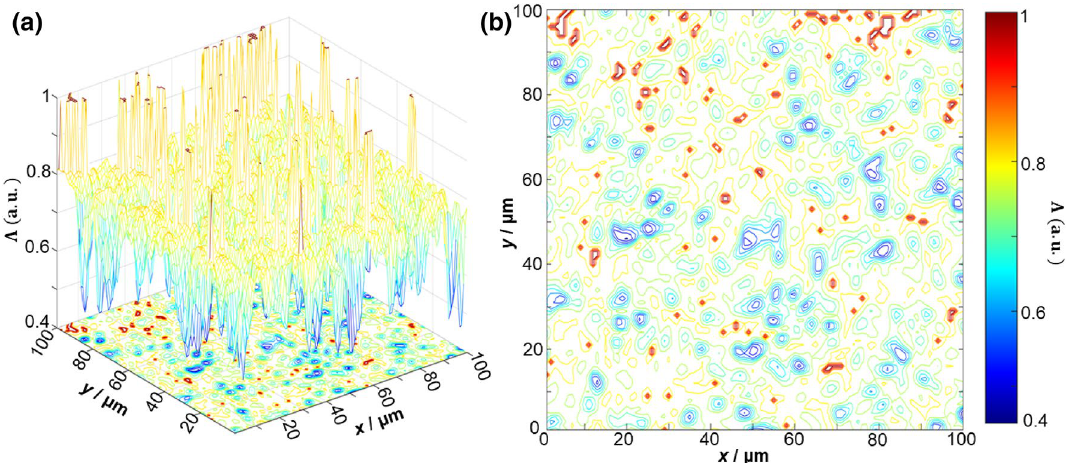
x , y , θ k = 0.85 rad of a sample of (cid:30) (cid:31)